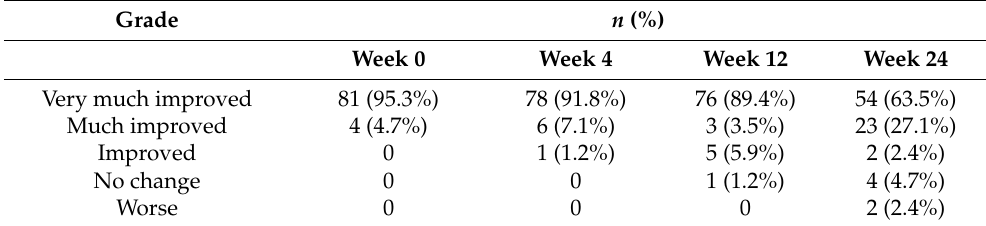
Table 2. Masked evaluation of aesthetic results using GAIS a .